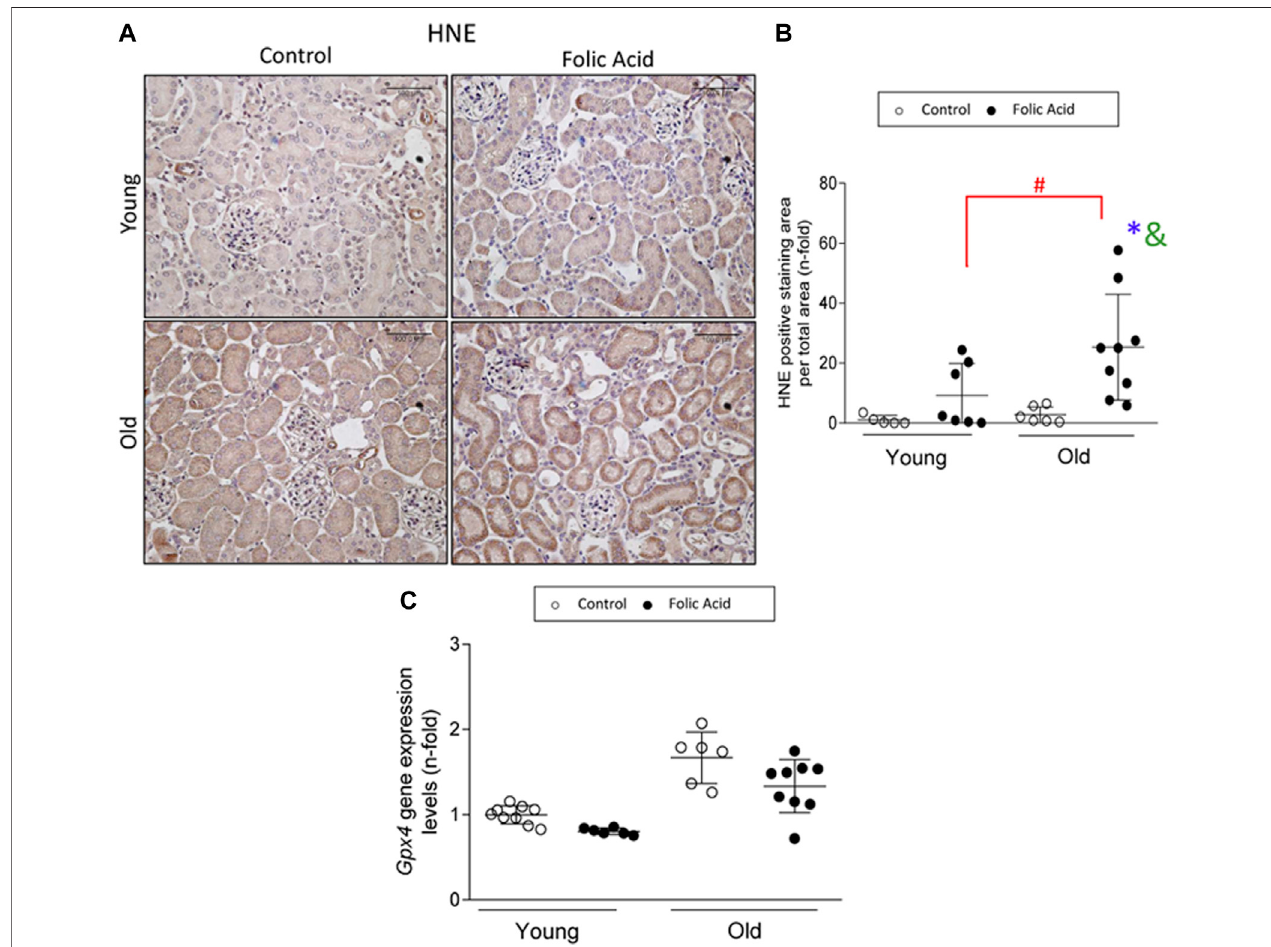
FIGURE 5 | Ferroptosis death pathway is signi fi cantly increased in FA-induced AKI in old vs. young mice. Folic Acid (FA; 125 mg/kg) was injected in 3-months-old (Young) and 1-year-old (Old) C57BL/6 and kidneys were studied after 48 h (A, B) 4-Hidroxynonenal (HNE) immunohistochemistry was performed. (A) Representative pictures from each group and (B) the quanti fi cation of stained area per total area was performed. (C) Renal gene expression levels of Gpx4 were studied by qRT-PCR. Scale bars (cid:2) 100 μ m. Data are expressed as mean ± SD of n (cid:2) 6 – 9 animals per group. * p < 0,05 vs. Young mice control. The non-parametric Kruskal-Wallis statistical test was